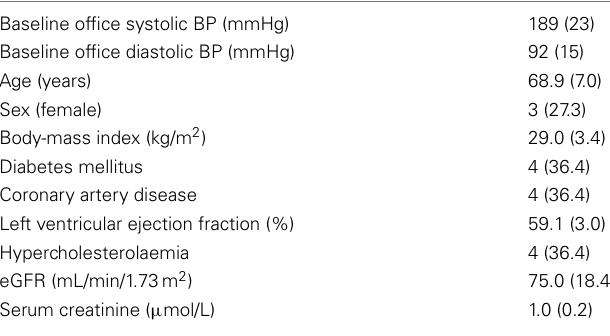
Table 1 | Baseline clinical characteristics and